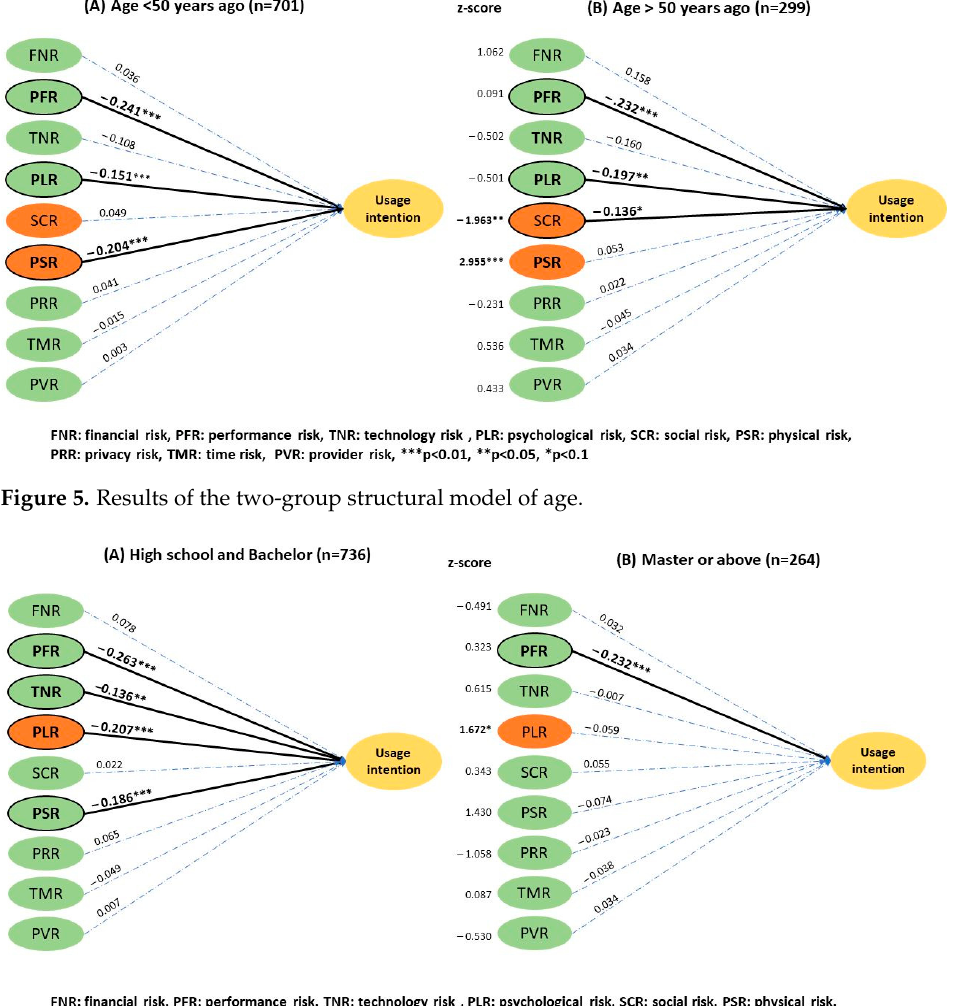
Figure 7. Results of the two-group structural model of monthly income. For telemedicine experience (Figure 8), the subgroup analysis showed that people with no experience (2.53 ± 0.88) perceived a higher physical risk than experienced users (2.26 ± 0.94), which affected their UI. The z score was − 2.27 ( p < 0.05). The analysis of the overall health condition (Figure 9) revealed that the group without major chronic diseases perceived a higher performance risk (3.45 ± 0.84) that influenced their UI compared to users with a history of chronic disease (3.17 ± 0.97) with a z score of − 6.076 ( p < 0.01).